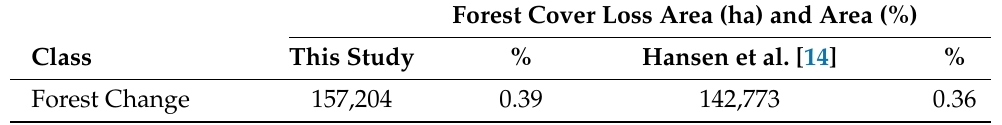
Table 11. Forest loss area for the year 2019 (this study) compared with global forest cover loss from Hansen et al. [14] version